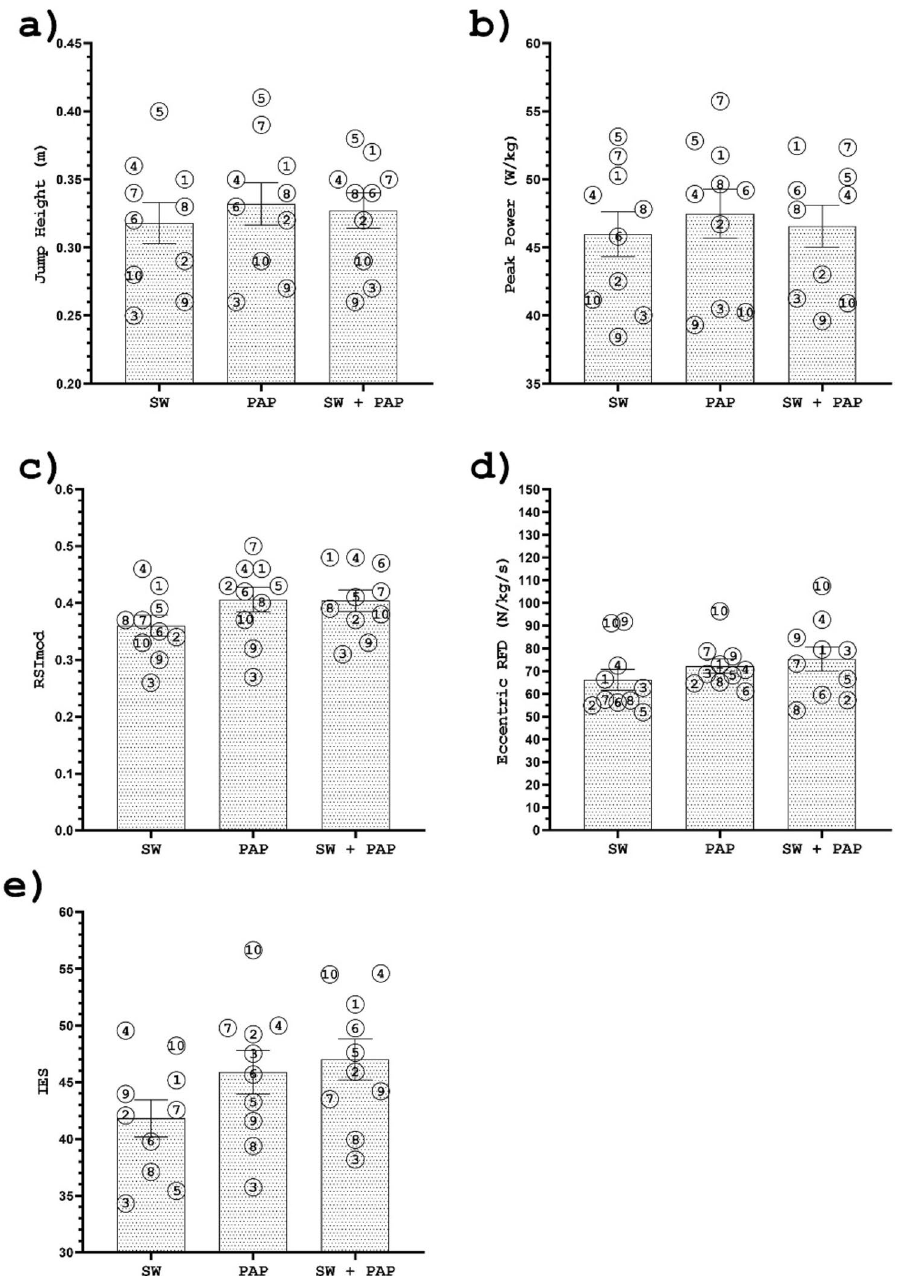
Figure 4. Individual responses for the jump height ( a ); peak power ( b ); the reactive strength index ( c ); eccentric RFD ( d ); and IES ( e ) after a swim-specific warm-up (SW), PAPE, and swim-specific warm-up with PAPE (SW + PAPE). The numbers indicate the athletes’ IDs. The results are plotted as mean ±